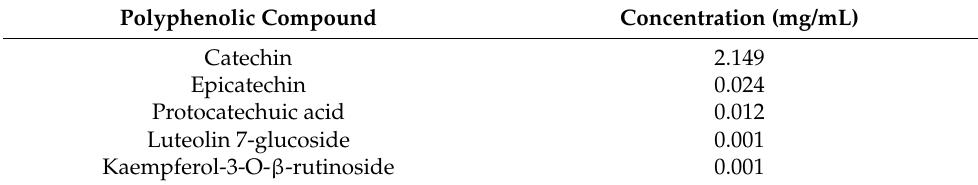
Table values are means of triplicate